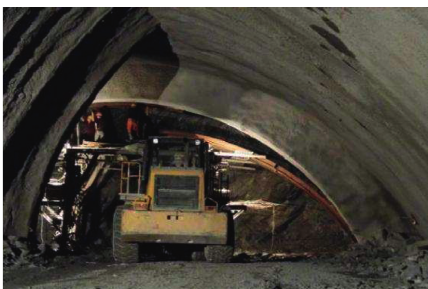
Figure 5: Stress distribution cloud diagram of the second lining.